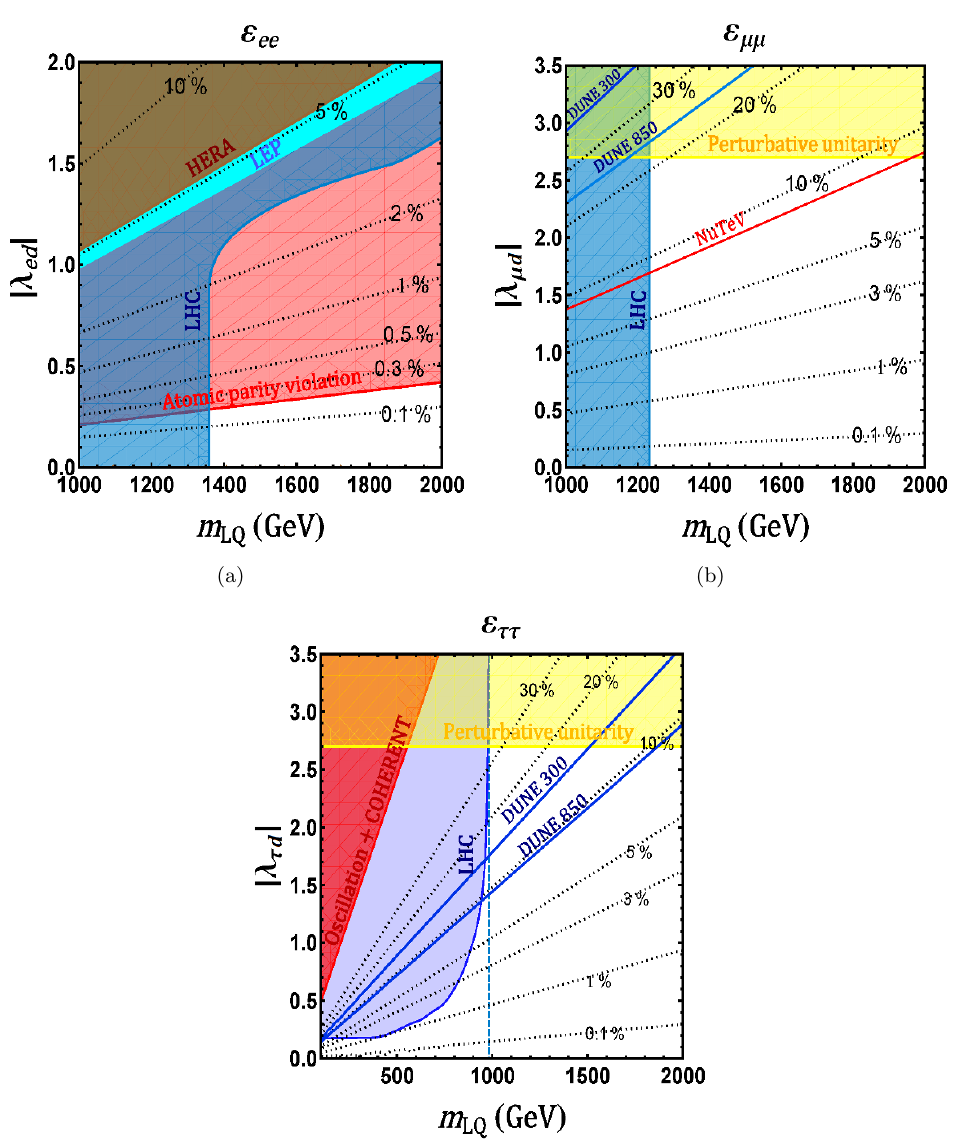
Figure 31 . Predictions for diagonal NSI ( " ee ; " (cid:22)(cid:22) ; " (cid:28)(cid:28) ) induced by doublet LQ in the one-loop LQ model are shown by black dotted contours. Color-shaded regions are excluded by various theoretical and experimental constraints. Yellow colored region is excluded by perturbativity constraint on LQ coupling (cid:21) (cid:11)d [192]. Blue-shaded region is excluded by LHC LQ searches ((cid:12)gure 29) in sub(cid:12)gure (a) by e +jets channel (pair production for small (cid:21) ed and single-production for large (cid:21) ed ), in sub(cid:12)gure (b) by (cid:22) +jets channel, and in sub(cid:12)gure (c) by (cid:23) +jet channel. In (a), the red, brown and cyan-shaded regions are excluded by the APV bound (cf. eq. 5.18), HERA and LEP contact interaction bounds (cf. table 16) respectively. In (b), the red line is the suggestive limit from NuTeV [146]. In (c), the red-shaded region is excluded by the global-(cid:12)t constraint from neutrino oscillation+COHERENT data [61]. We also show the future DUNE sensitivity in blue solid lines for both 300 kt.MW.yr and 850 kt.MW.yr [66].